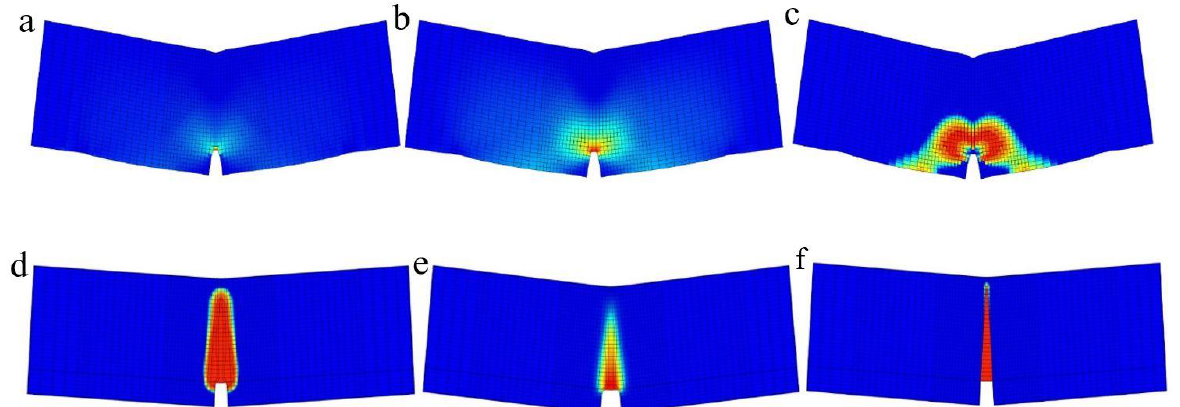
Figure 8. Crack propagation path under mode I loading: For mild steel ( a ) strain crack band, ( b ) strain implicit gradient, ( c ) damage implicit gradient, for Fe-based amorphous ( d ) strain crack band, ( e ) strain implicit gradient, and ( f ) damage implicit gradient.